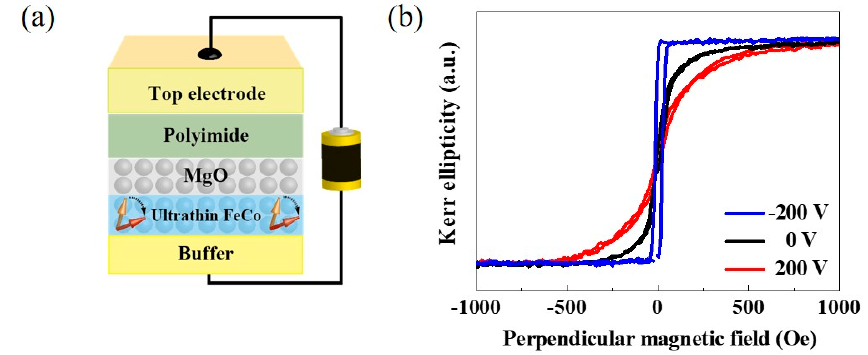
Figure 2. ( a ) Schematic illustration of sample stack used for the first demonstration of the voltage-controlled magnetic anisotropy (VCMA) effect in an all-solid state structure, and ( b ) applied bias voltage dependence of the polar-magneto-optical Kerr effect (MOKE) hysteresis curves for a 0.58 nm-thick Fe 80 Co 20 layer.